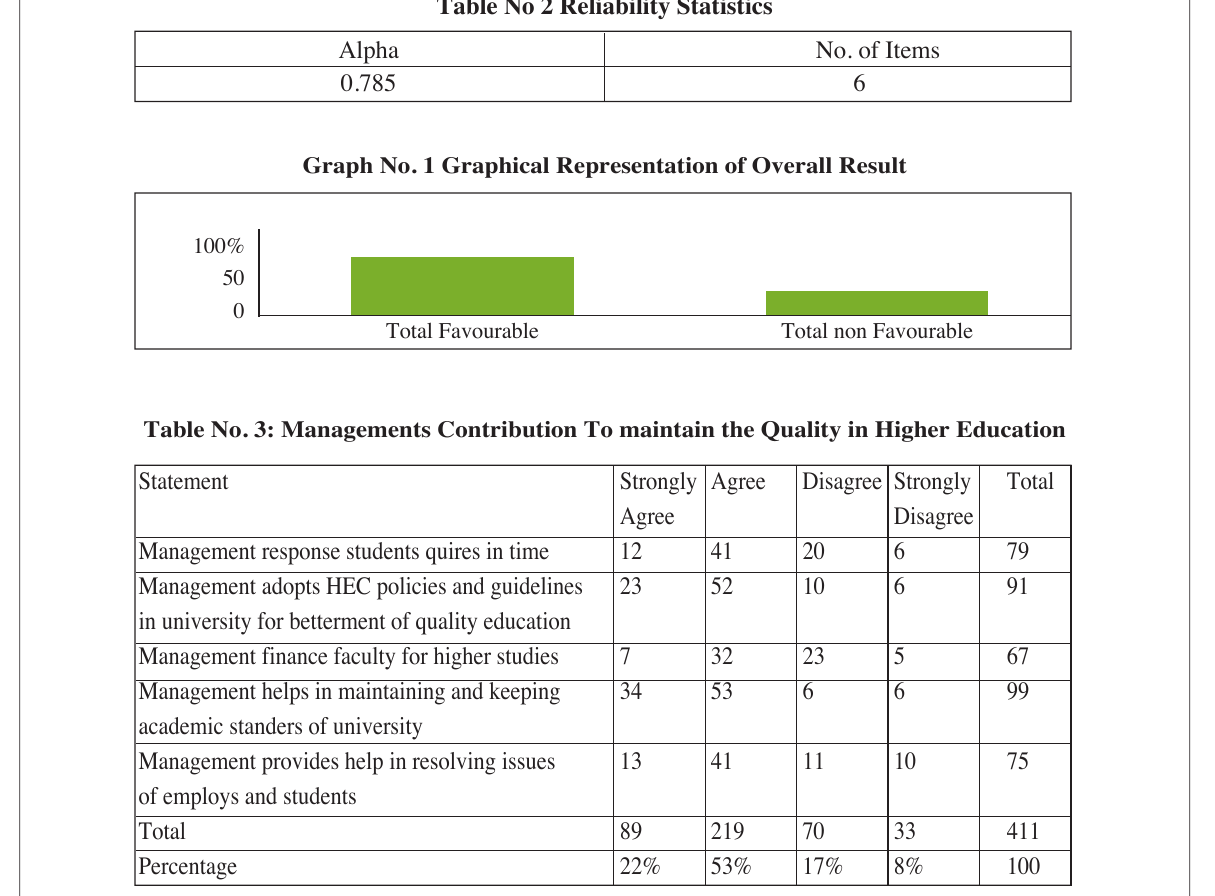
Table No: 1 Pilot test of Questionnaire